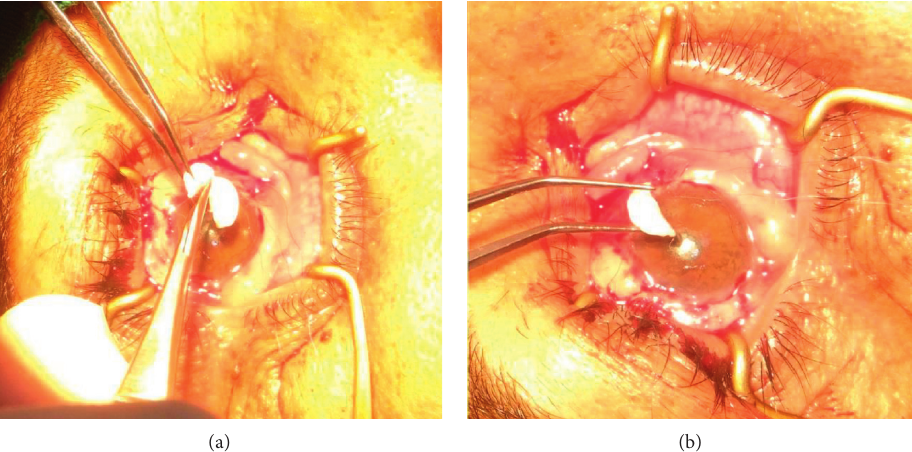
Figure 2: Ologen implantation: (a) cutting Ologen disc into two halves; (b) implanting Ologen under the graft before securing it in